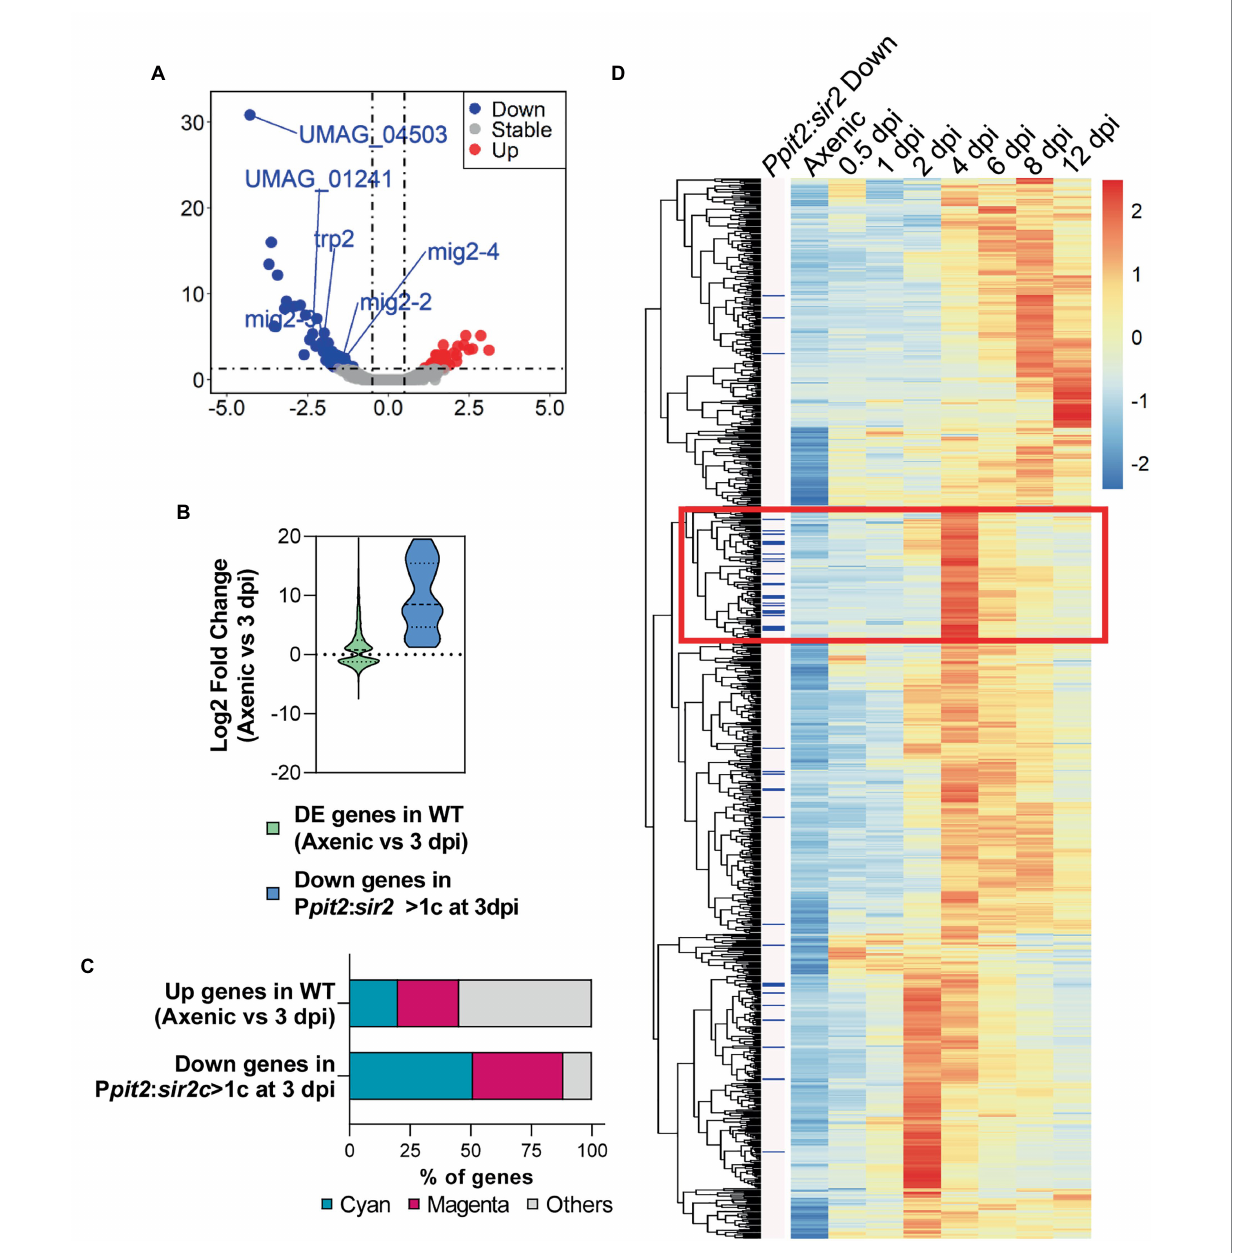
FIGURE 5 Overexpression of sir2 during pathogenesis avoids the proper activation of a subpopulation of genes related to biotrophism establishment and tumorigenesis. (A) Volcano plot showing the log2 fold change in gene expression and the statistical significance of the differential expression analysis from RNA-seq data obtained in the P pit2 : sir2 > 1c mutant compared to wild-type at 3 dpi. Red, blue and grey dots represent the upregulated genes (log2 fold change ≥ 0.5, adj p -value < 0.05), downregulated genes (log2 fold change ≤ − 0.5 adj p -value < 0.05) and genes without changes in the P pit2 : sir2 > 1c mutant, respectively. sir2 and sdh2 (integration resistance cassette used for over expression mutant) data have been removed for plotting purpose. (B) Log2 fold change distribution of the differentially expressed genes (adj p -value < 0.05) at 3 dpi compared to axenic conditions in wild-type and the downregulated genes in the P pit2 : sir2 > 1c mutant compared to wild-type at 3dpi. (C) Percentage of genes belonging to the magenta or cyan modules of coexpressed genes during infection for the upregulated genes of wild-type at 3 dpi compared to axenic culture and for the downregulated genes in the P pit2 : sir2 > 1c mutant compared to wild-type at 3 dpi. (D) Clustering analysis of the expression profile of genes belonging to the cyan and magenta modules in axenic cultures and the indicated dpi for the wild-type strain (normalized counts obtained from the published RNA-seq data (Lanver et al., 2018). Heatmap color-scale values correspond to the Z-score transformation of the expression data, with +2 (red) being the highest expression and-2 (blue) being the lowest expression. Blue bars on the left indicate the downregulated genes in the P pit2 : sir2 > 1c mutant at 3 dpi compared to